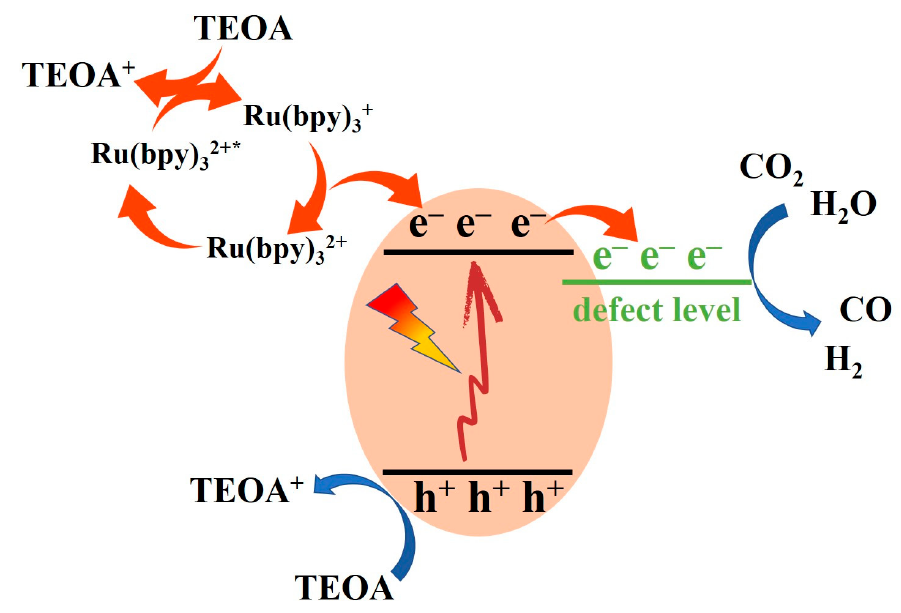
Figure 10. Possible photoreduction mechanism of CO 2 on N-NiO-x (* represents the excited state).